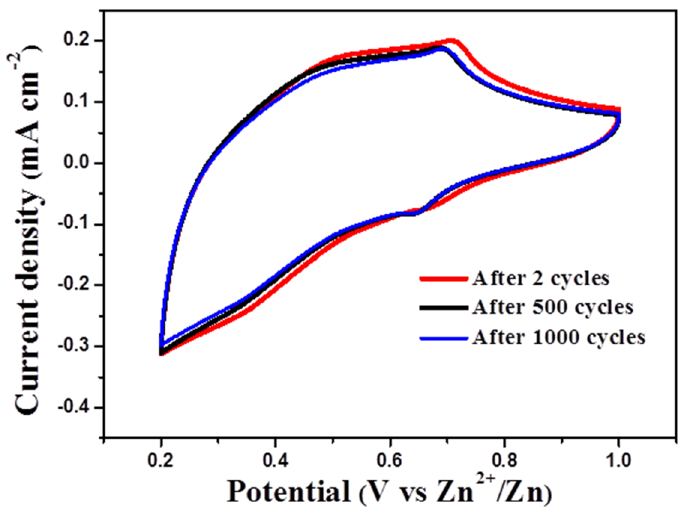
Figure 6. The durability test of the WO 3 nanosheets for 1000 cycles in the potential range from 0.2 to 1.0 V. Table 2. Properties comparison of WO 3 thin films based on near-infrared